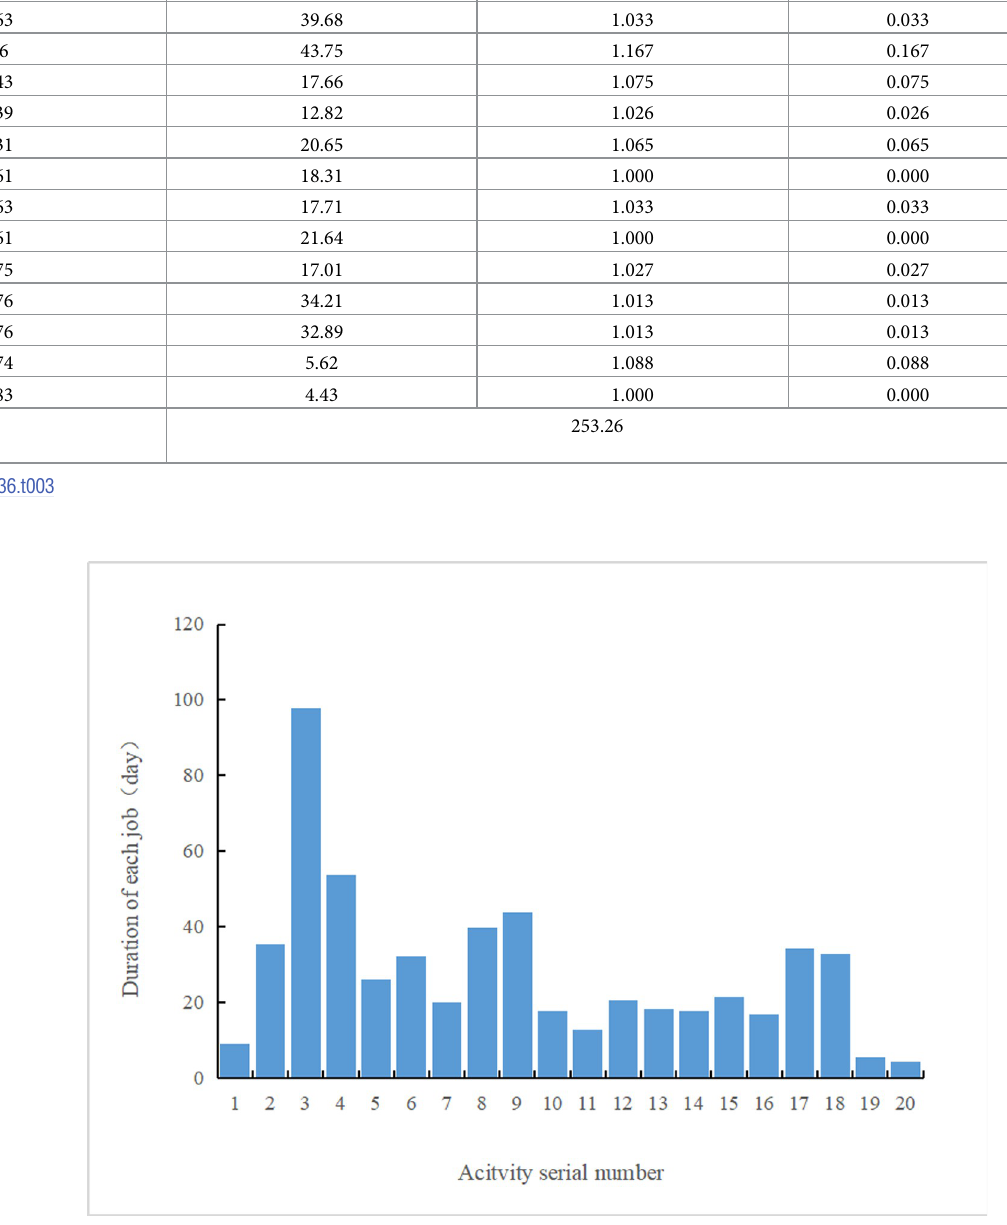
Fig 4. Duration of each